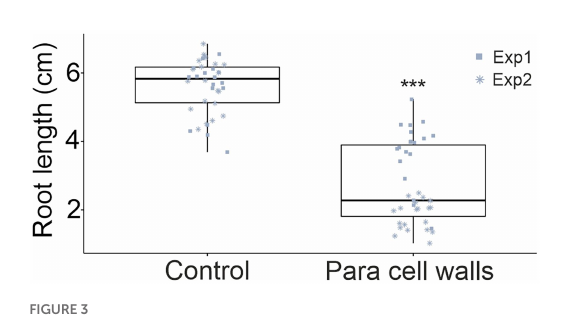
FIGURE 3 Inhibition of Arabidopsis growth by P. arabidopsidicola cell wall preparations. Arabidopsis growth was quantified in an in vitro root growth assay that measured root length of 14-day-old seedlings that had been grown for 10 days on vertically oriented 0.5× MS agar plates without (Control) or with addition of 0.9 g/l P. arabidopsidicola cell walls (Para cell walls). The experiment was replicated in two independent biological repeats and pooled data is presented ( n = 19 in each repeat, total n = 38). Statistical significance was tested using two-way ANOVA in R (v3.5.1), the treatment effect was significant (*** p = 2 × 10 − 16 ). The pooled data is displayed in standard boxplots; all data points are plotted with a different shape for each independent biological